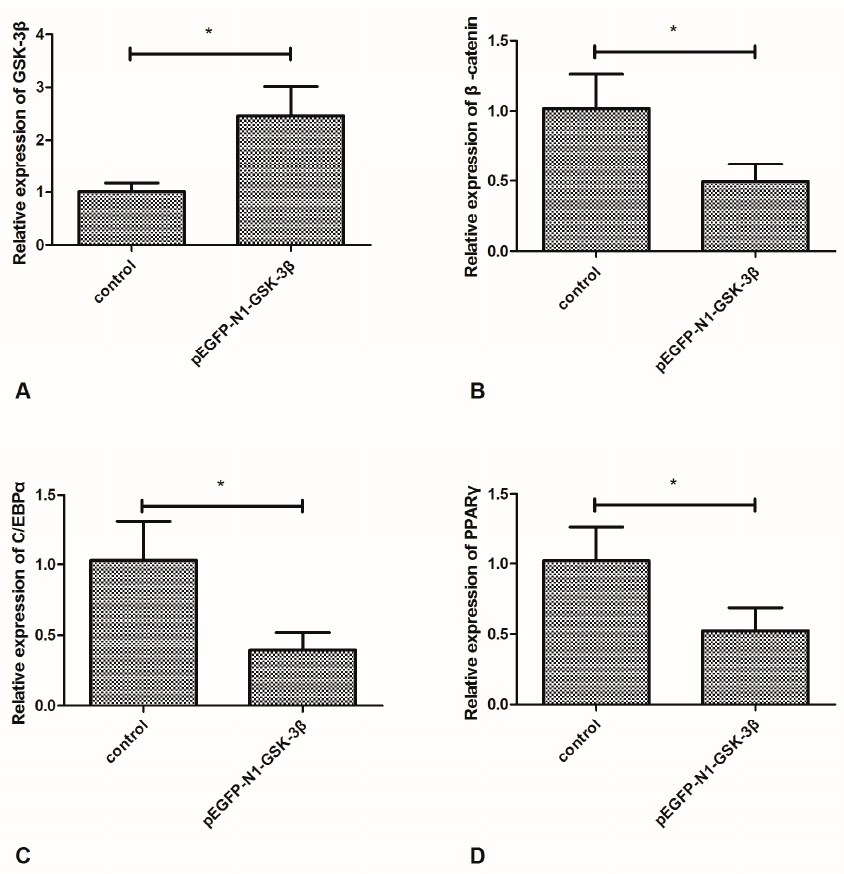
Figure 2. Effect of the pEGFP-N1-GSK-3 β vector on the mRNA expression of GSK-3 β , β -catenin, C/EBP α , and PPAR γ in the muscle of zebrafish. ( A ) GSK-3 β ; ( B ) β -catenin; ( C ) C/EBP α ; ( D ) PPAR γ . Values are expressed as means ± s.e.m. ( n = 6). Statistically significant differences are denoted by asterisk ( p < 0.05).